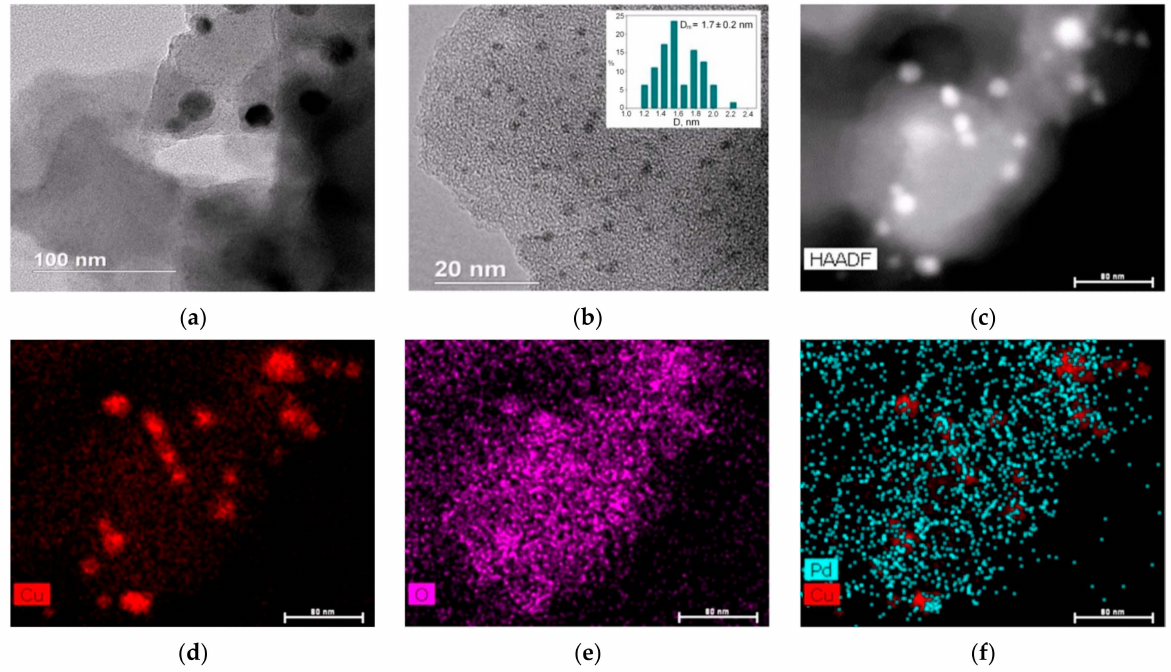
Figure 4. Bright-field ( a , b ) and dark-field ( c ) (scale 80 nm) STEM images of the reduced sample 1%-PdCu/HPS-R and EDX mapping of the Cu ( d ), O ( e ), and Cu-Pd superposition ( f ) (scales 80